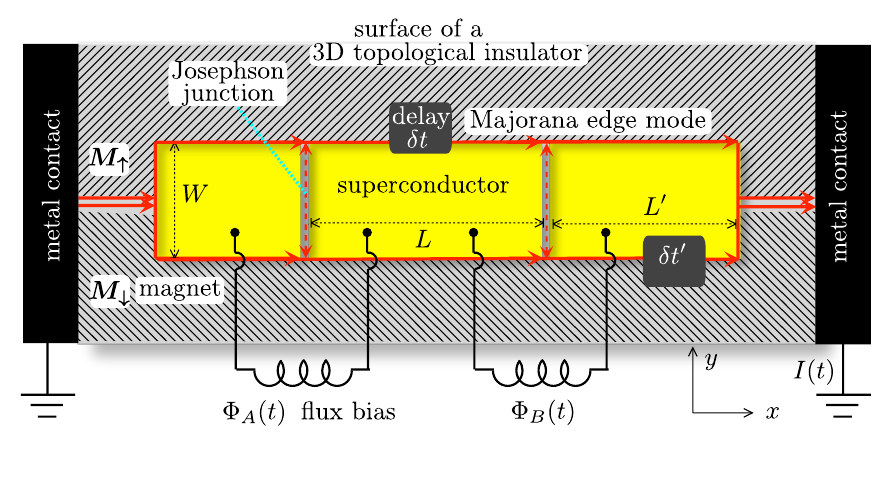
Figure 1: Geometry to create and braid two pairs of edge vortices in a topological insulator / magnetic insulator / superconductor heterostructure. The edge vortices are created at opposite ends of a Josephson junction, by an h / 2 e flux bias Φ induces a 2 π increment of the superconducting phase difference φ junction. Each edge vortex contains a Majorana zero-mode and two zero-modes de- fine a fermion-parity qubit. When two edge vortices are fused at the normal metal contact a current pulse I ( t ) is produced, of integrated charge Q = ± e / 2. Gate elec- trodes on the edge modify the velocity of propagation and allow for a relative delay of vortices at upper and lower edge. This makes it possible to braid their world lines, as illustrated in Fig. 5. The braiding is a non-Abelian exchange operation which switches the fermion parity of the qubit and flips the sign of Q , allowing for